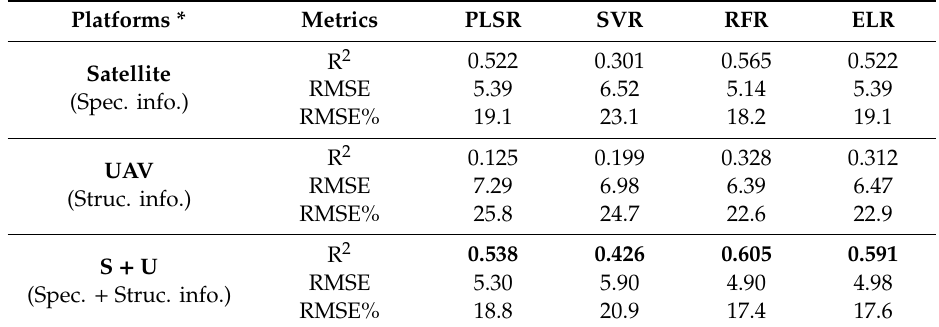
Table 6. Testing results of PLSR, SVR, RFR, and ELR methods for nitrogen concentration (N) estimation.